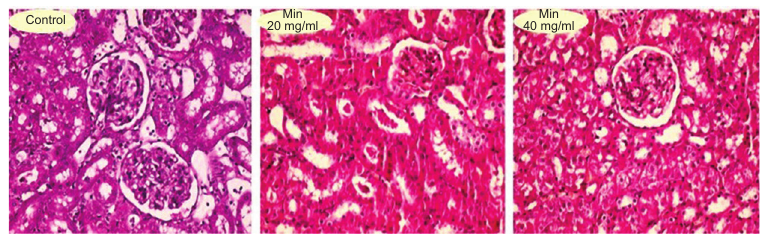
Figure 4 . Kidney tissue histopathological alterations in manganese-exposed animals. Hematoxylin and eosin staining. The grades of histopathological changes are given in Table 3.